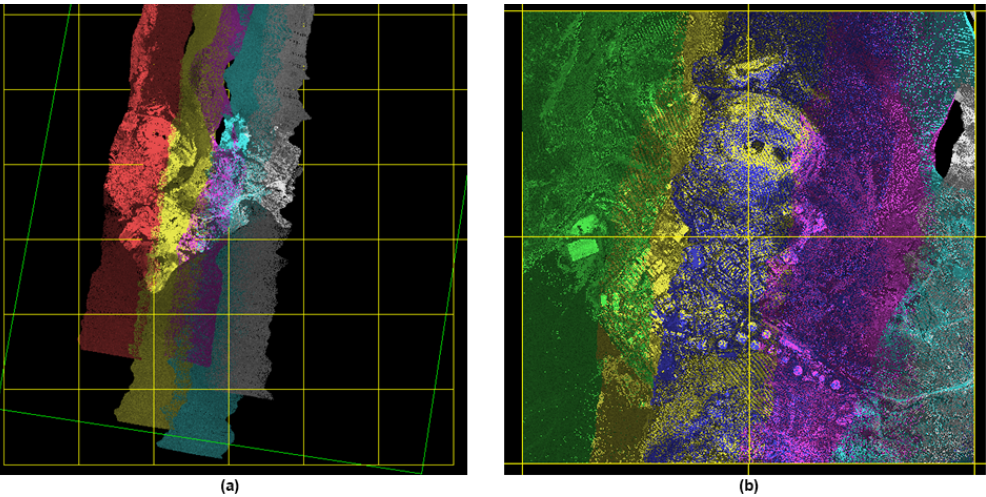
Figure 6. Lidar point cloud strips and point cloud tiles illustrating how a large coverage area is broken down into tiles. (a) Five flight strips over McMurdo Station; the strip point clouds have been rendered based on flight line and intensity. The yellow grid represents the 1km × 1km tiles into which the returns from the different strips will be binned. (b) Point clouds for four tiles. The tiled point clouds are rendered based on flight line and intensity. The overlap between the different flight strips within each tile is evident on this